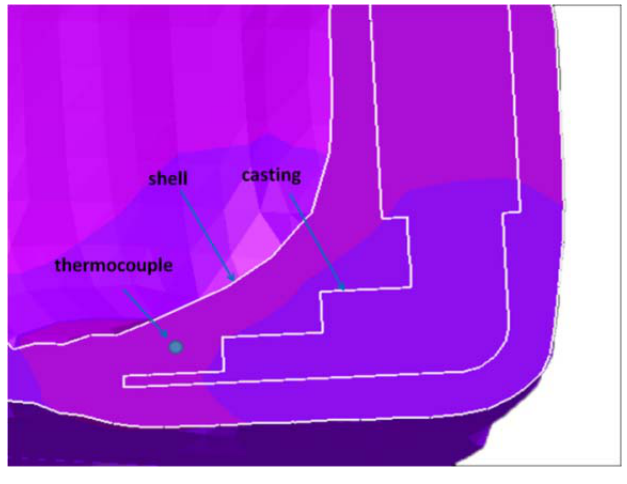
Figure 4. The relative position of